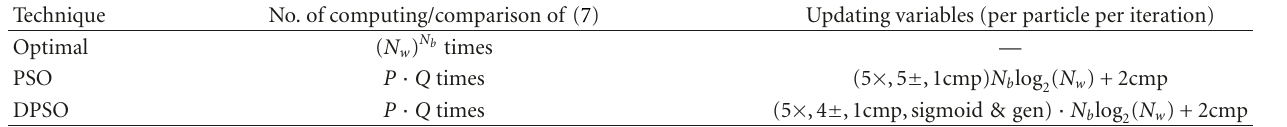
Algorithm 2: Location update for DPSO.